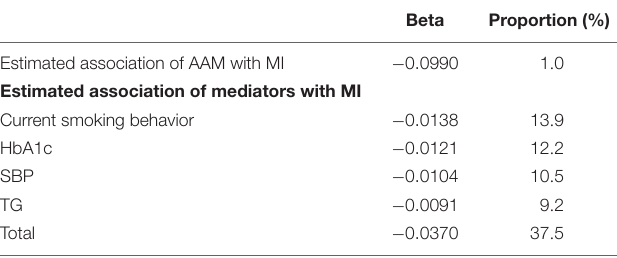
6.11, p = 0.021) and genetically predicted higher levels of FBG TABLE 1 | MR analyses of association of genetically predicted AAM with genetically predicted risk of MI and mediation explained by risk